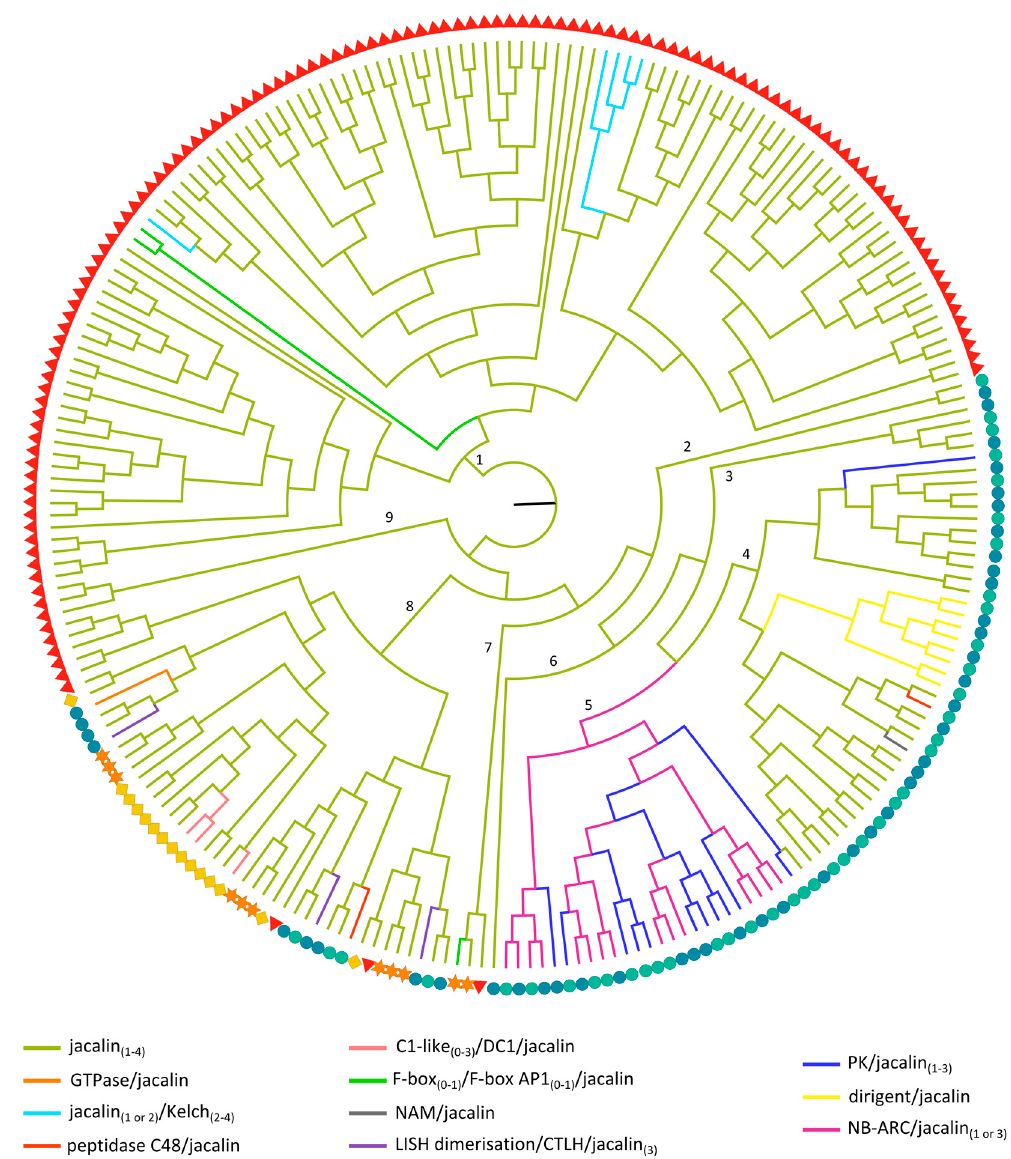
Figure 5. Evolutionary relationships of JRL sequences from Arabidopsis (red triangle), soybean (orange star), cucumber (yellow rhomb) and rice ( japonica : green circle, indica : blue circle). The colored branches of the midpoint rooted maximum likelihood tree reflect different domain architectures of the full-length JRL sequences and the numbers specify the clade number.